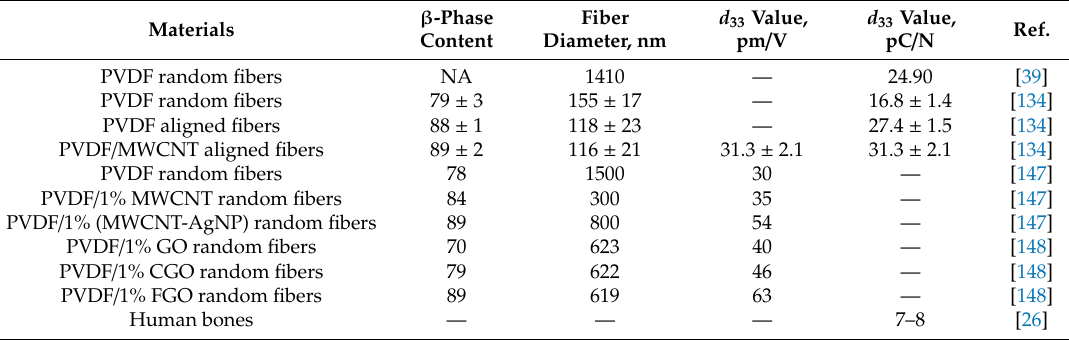
Table 1. Effect of β -phase content on piezoelectric coefficient of electrospun PVDF and its nanocomposite mats. E ff ect of β -phase content on piezoelectric coe ffi cient of electrospun PVDF and its nanocomposite mats.